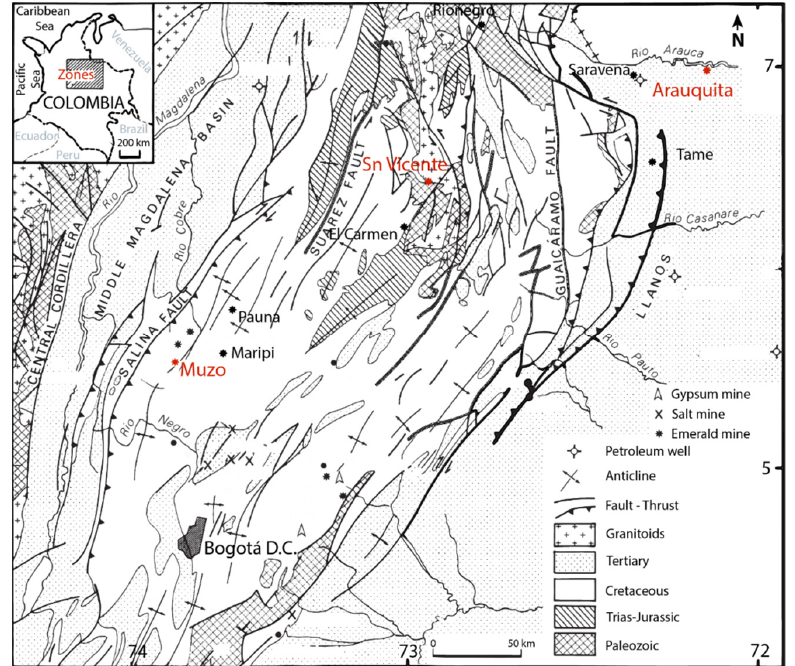
Figure 2. Locations of the assessed farms in the municipalities of San Vicente de Chucurí, Arauquita, and Muzo (in red), part of the major cacao producing districts in Colombia (Santander, Arauca, and Boyacá, respectively). As shown on the map, the presence of geological faults/granitoids formations, emerald mines, and petroleum pipelines near the farms are